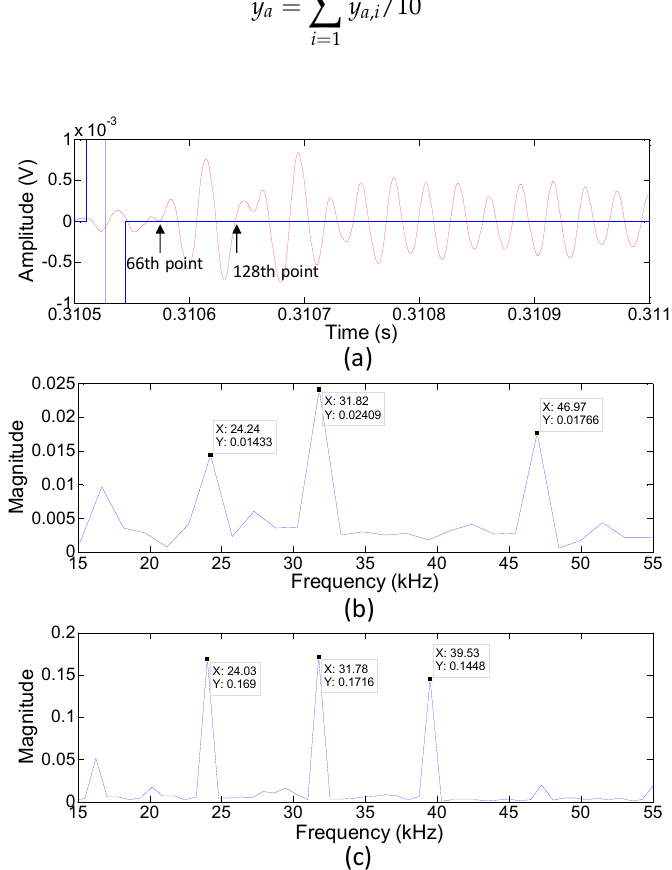
Figure 9. ( a ) The raw signal from the microphone processed with a third-order Butterworth bandpass filter. ( b , c ) The frequency responses of the processed microphone signal from the occasion at the beginning of the input signal to the positions of the 66th point and 128th point, respectively.